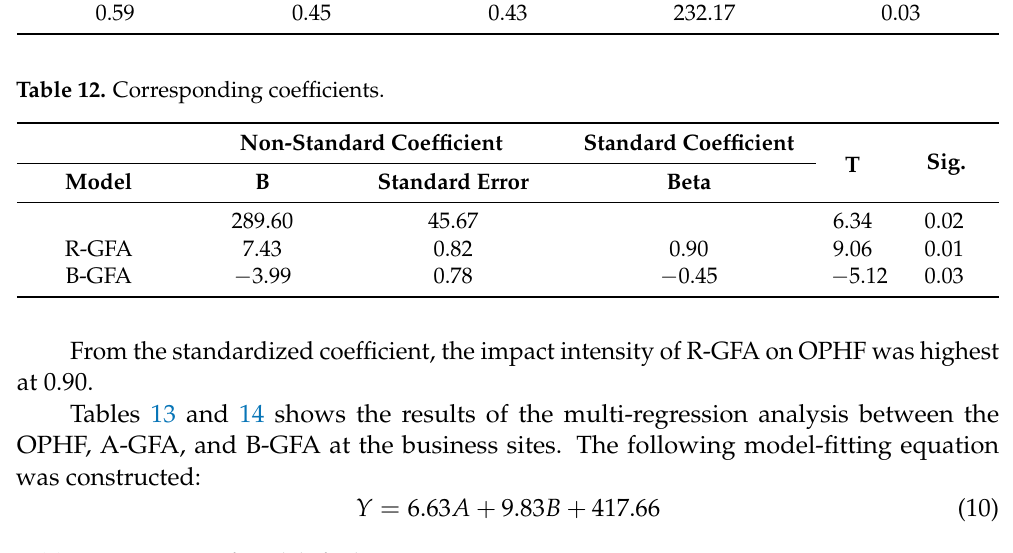
Table 13. Summary of models for business sites.